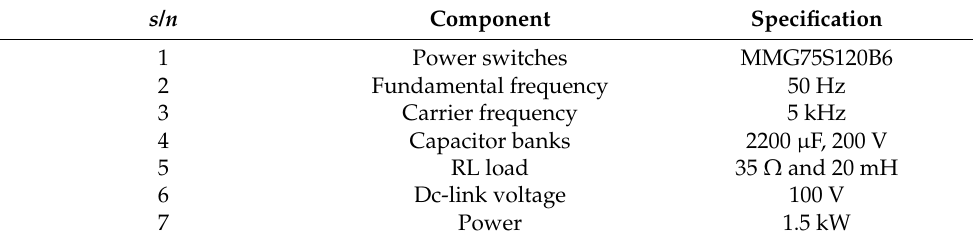
Table 3. Prototype